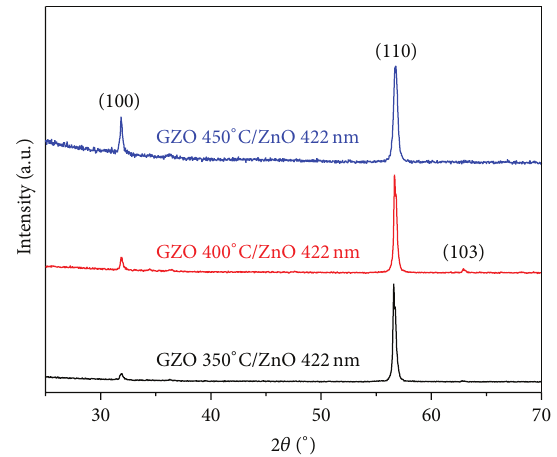
Figure 6: X-ray diffraction patterns of the GZO film grown on a thick 422 nm ZnO buffer layer at different deposition